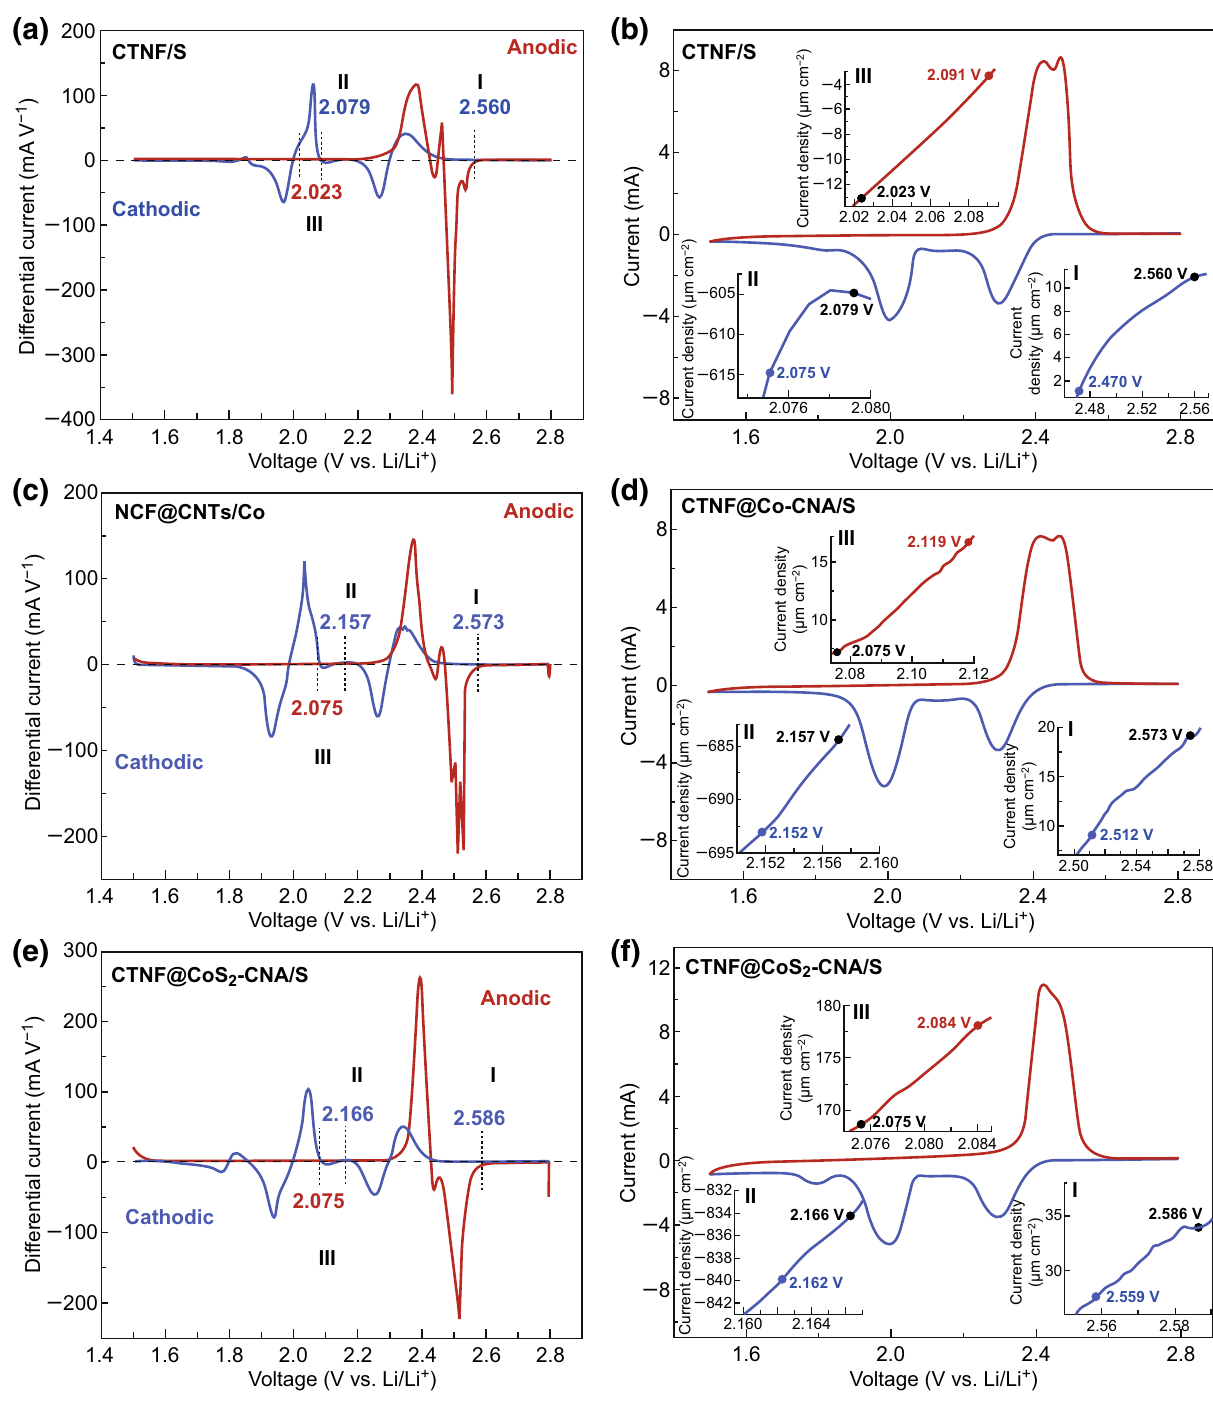
Fig. 5 Electrocatalytic effects of electrode materials verified from the CV profiles: a , c , e differential CV curves and b , d , f CV curves of CTNF/S, CTNF@Co–CNA/S, and CTNF@CoS 2 –CNA/S electrodes. The corresponding onset potentials of redox peaks are provided in ( b , d , f ). The baseline potentials and baseline current densities in ( a, c, e ) are defined as the values before the redox peaks, where the variation on current density is the smallest, namely d I /d V =